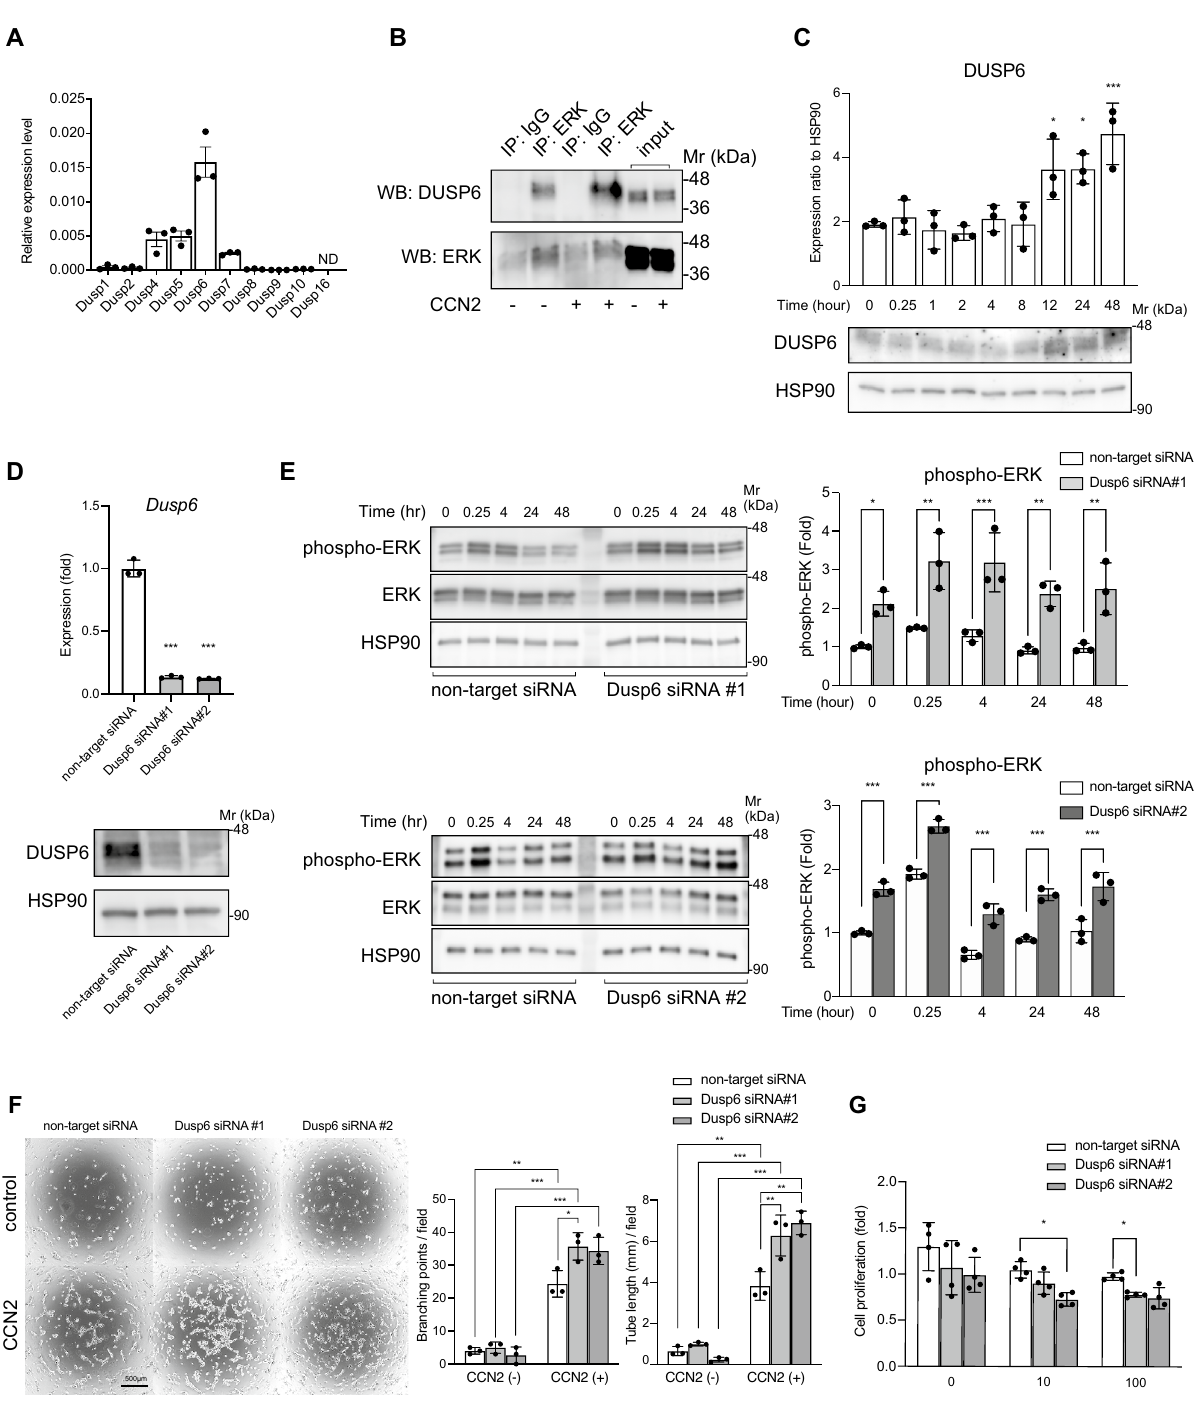
0 . 100 Figure 6. DUSP6 interacts with ERK and suppression of DUSP6 increases phospho-ERK levels and tube formation. ( A ) Expression levels of Dusp1 , -2 , -4 , -5 , -6 , -7 , -8 , -9, -10 and -16 in LECs. ND, not detected. ( B ) Cell lysates from LECs stimulated with 100 ng/mL of CCN2 for 2 h or control cells were immunoprecipitated with anti-ERK antibody (ERK) or normal rabbit IgG (IgG) and analyzed by Western blot with antibodies against DUSP6 or ERK. ( C ) Expression levels of DUSP6 protein in LECs treated with CCN2 for 0, 0.25, 1, 2, 4, 8, 12, 24, and 48 h. ( D ) Suppression of DUSP6 by siRNA. mRNA expression levels (upper) and protein levels (lower) in LECs transfected with non-target siRNA or DUSP6 siRNA. One-way ANOVA, *** p < 0.001 versus non-target siRNA. ( E ) Phospho-ERK levels in LECs transfected with non-target siRNA or DUSP6 siRNA, and treated with 100 ng/mL CCN2 for 0, 0.25, 4, 24 or 48 h. phospho-ERK levels were quantified and normalized with total ERK levels. Two-way ANOVA, * p < 0.05, ** p < 0.01, *** p < 0.001, versus non-target siRNA. ( F ) LECs were transfected with siRNA against Dusp6 and plated onto Matrigel containing CCN2. The cells were cultured for 8 h, fixed in 4% PFA, stained with calcein AM, and the number of branch points and tube lengths were evaluated. Two-way ANOVA, * p < 0.05, ** p < 0.01, *** p < 0.001. ( G ) LECs were transfected with siRNA against Dusp6 and proliferation assay was